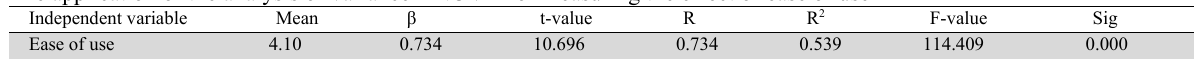
Pearson Correlation Sig. (2-tailed)